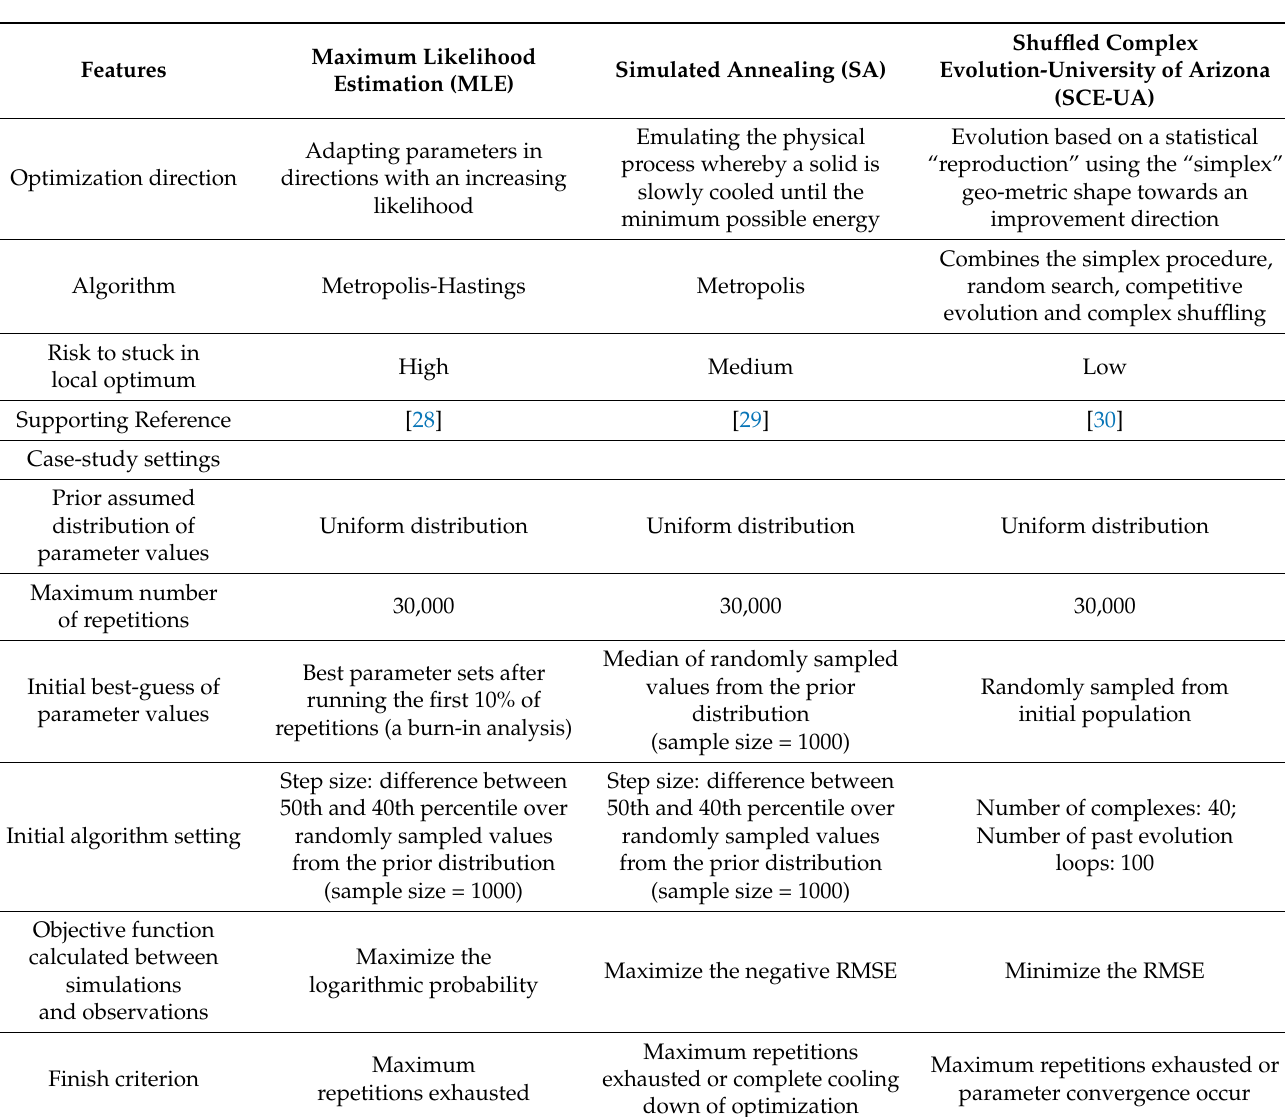
Table 3. A brief summary of the features and user-specified settings for the three employed optimiza- tion